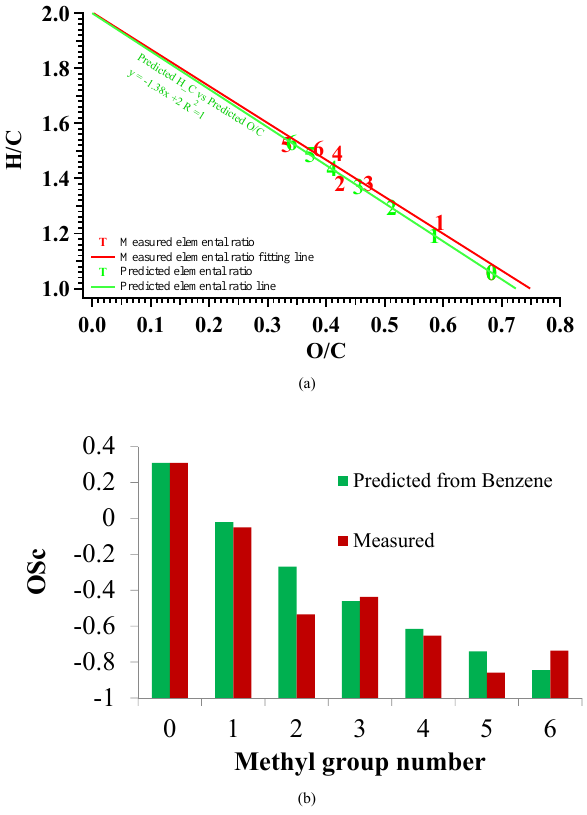
Figure 4. Comparison of predicted and measured O/C and H/C (a) as well as oxidation state (OSc) (b) in SOA formation from monocyclic aromatic hydrocarbon photooxidation under low NO x (benzene 1223A; toluene 1468A; m -xylene 1191A; 1,2,4- trimethylbenzene 1119A; 1,2,4,5-tetramethylbenzene 1306A; pen- tamethylbenzene 1627A; hexamethylbenzene 1557A).